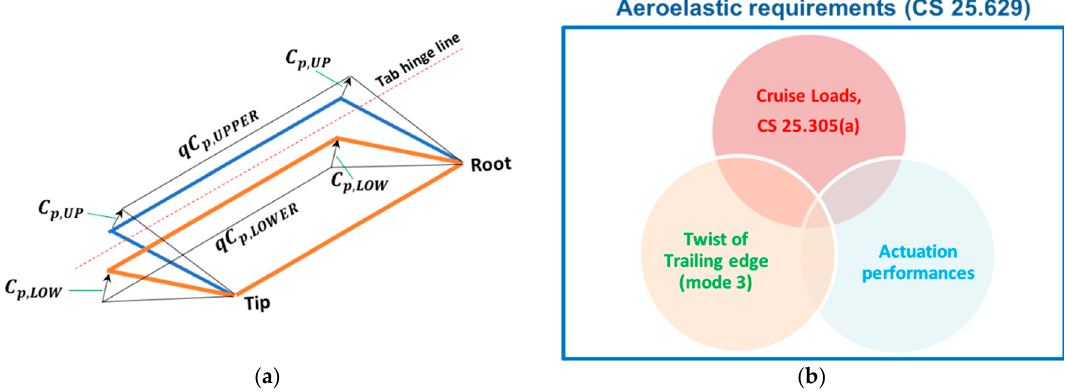
Figure 6. Design condition: ( a ) Pressure distribution on TE upper and lower surfaces for limit load condition; ( b ) Requirements simultaneously fulfilled to integrate a multifunctional TE at aircraft level.